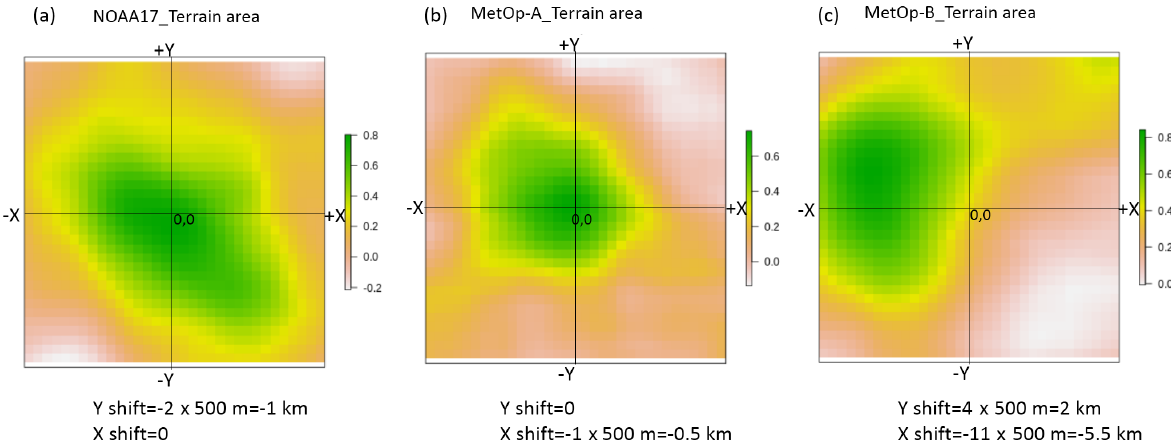
Figure 4. Variations in the correlation with respect to each shift combination. Only the results of one patch from the NOAA-17 (a) , MetOp- A (b) and MetOp-B (c) scenes are shown for